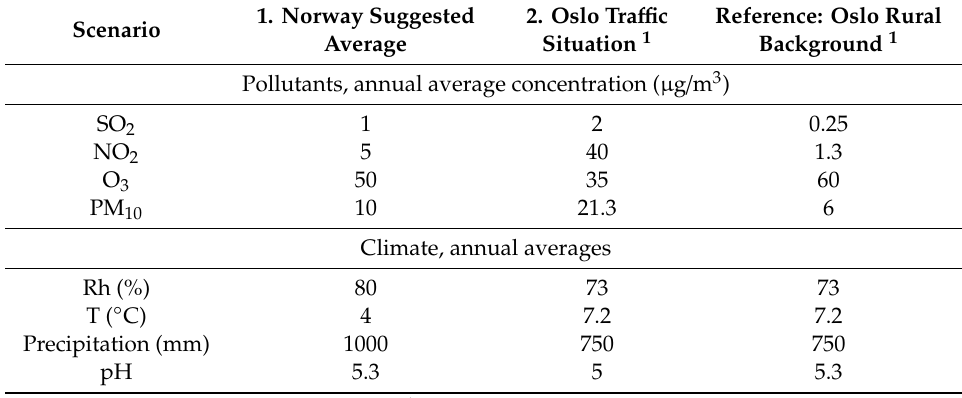
Table 3. Atmospheric parameter values for the Norwegian and Oslo scenarios and reference values for the rural background to Oslo, representing an approximate year 2020 situation. Rh = relative humidity, T = temperature and pH = acidity in rainwater.